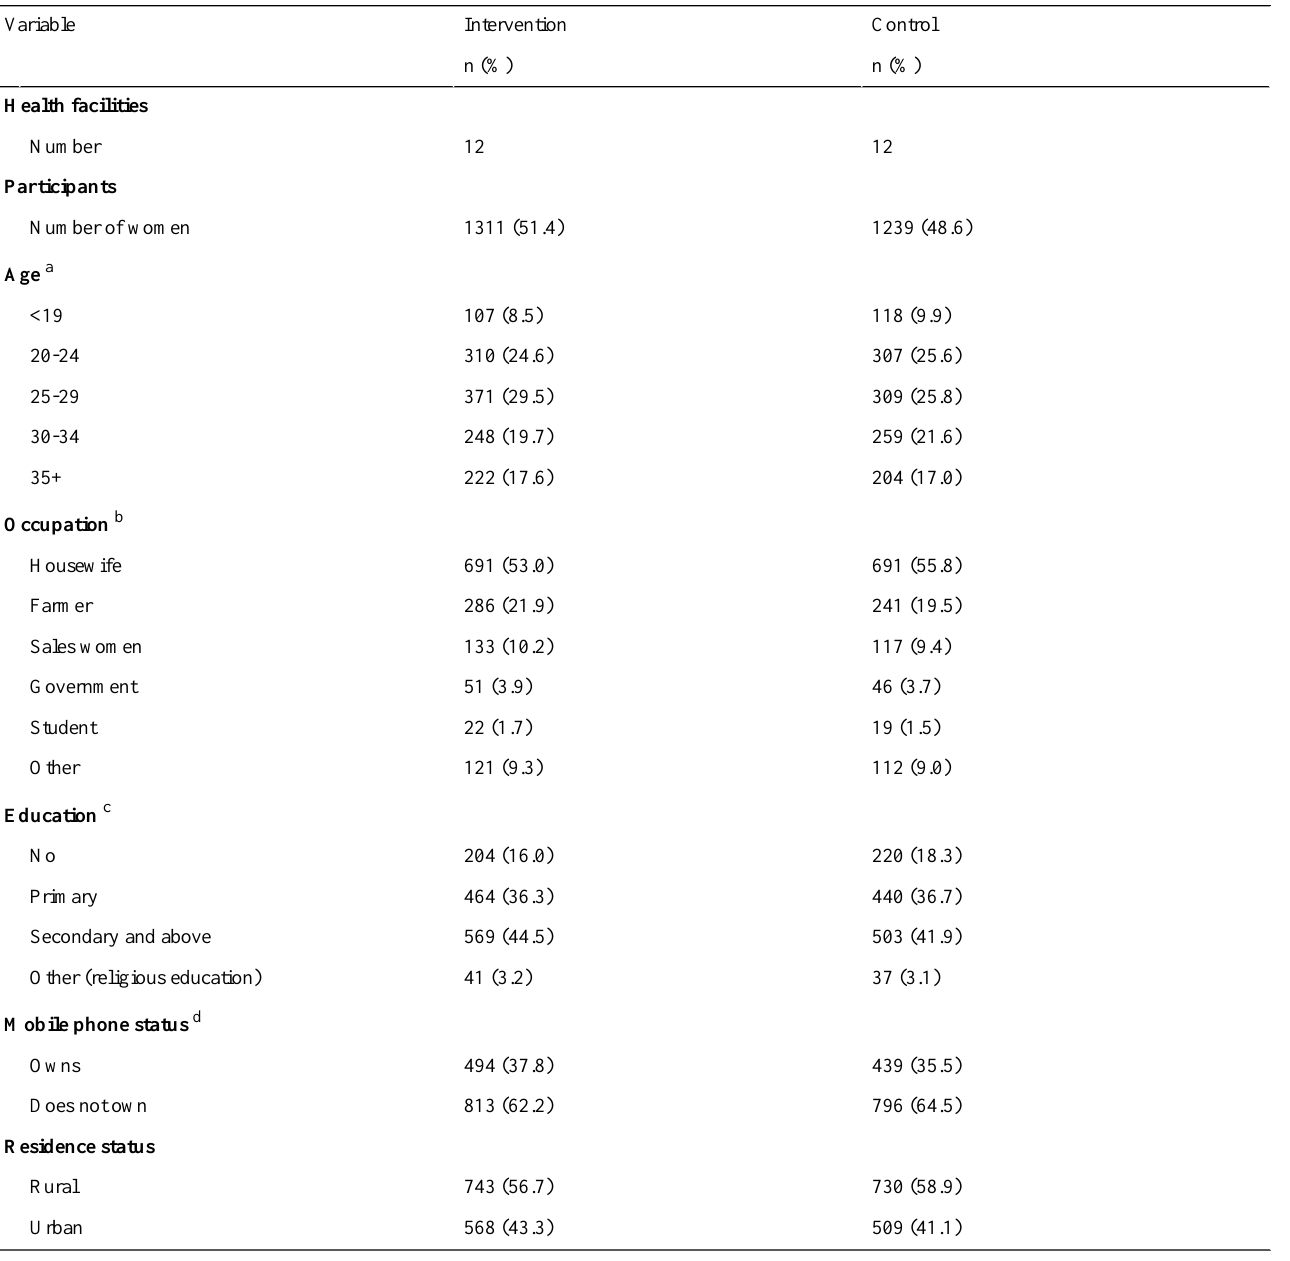
Table 1. Socioeconomic characteristics of study